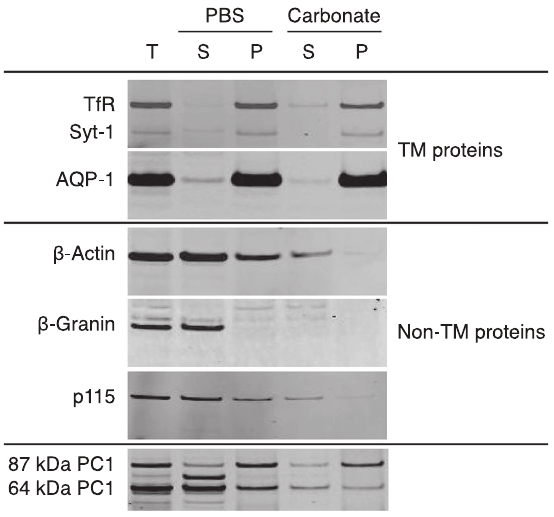
Figure 1. Carbonate extraction of AtT20 cells. AtT20 cells were subjected to extraction by PBS followed by 0.1 M sodium carbonate, pH 11.5. Equivalent volumes from each step were analyzed by Western blot. Three TM proteins (transferrin receptor (TfR), synaptotagmin 1 (Syt-1) and aquaporin 1 (AQP-1) and 3 non- TM proteins ( b -actin, b -granin and p115) were analyzed as controls. The 3 TM proteins were recovered in the sodium carbonate pellet while the 3 non-TM proteins were predominantly recovered in the PBS supernantant. The distribution of PC1 was also analyzed. The 64 kDa form was predominantly recovered in the PBS supernatant while the 87 kDa form (and a small amount of the 64 kDa form) was predominantly recovered in the carbonate pellet. This suggested that the 87 kDa form and some of the 64 kDa form of PC1 have properties consistent with a TM protein. T, total; S, supernatant; P, pellet.